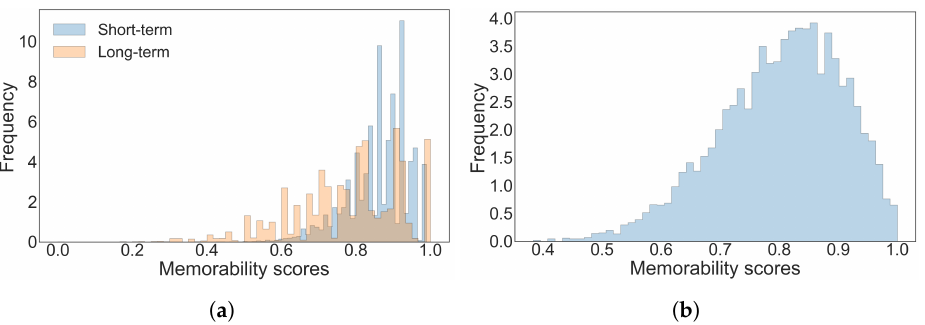
Figure 2. Memorability ground-truth label distribution for the three datasets used in our study. All of them are skewed towards high-memorability scores. ( a ) VideoMem’s distribution of scores; ( b ) Memento10K’s distribution of